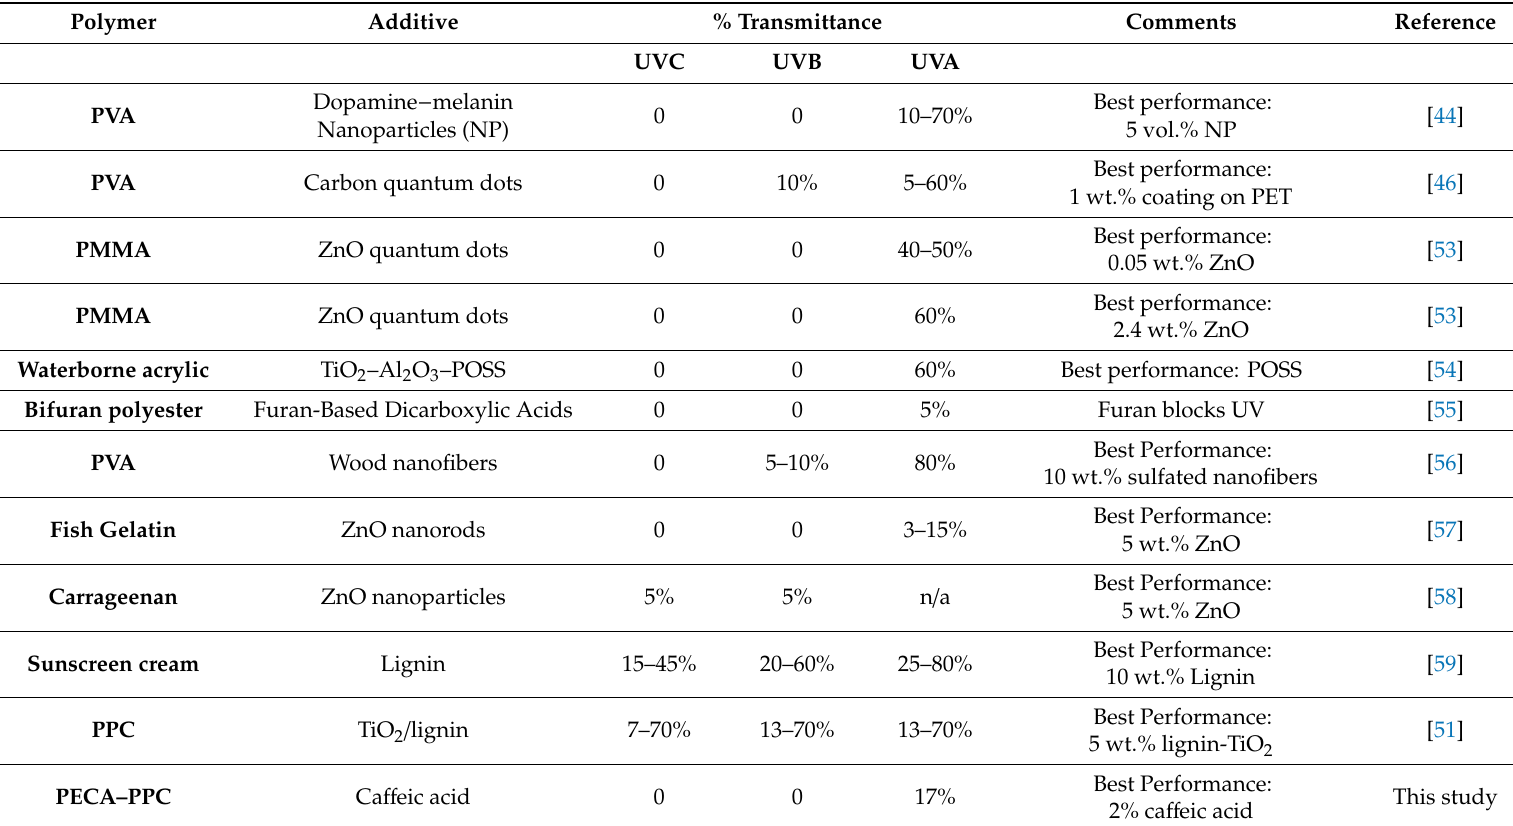
Table 2. UV blocking properties of di ff erent polymeric systems reported in literature. They are compared against the best performing sample from this study. Abbreviations, PVA: Polyvinyl alcohol; POSS: Polyhedral oligomeric silsesquioxanes; PMMA: Polymethyl